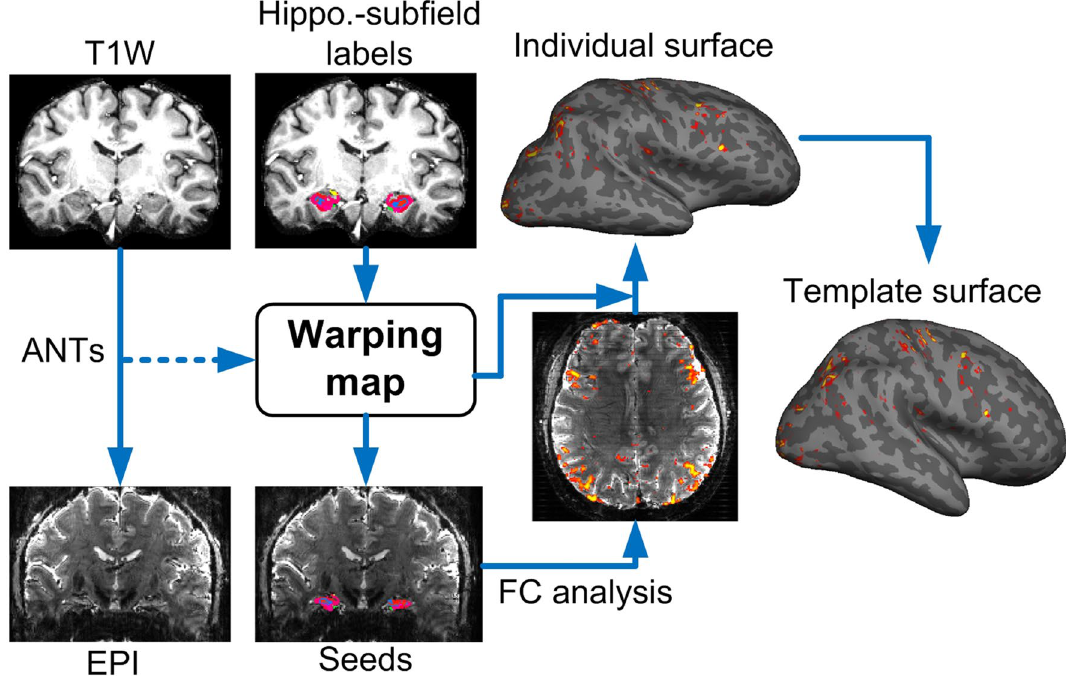
Figure 1. The procedures of coregistration. Individual T1-weighted images were coregistered to the EPI by ANTs. The warping coefficients were then applied to the labeled images of the hippocampal subfields. The seed- based FC analysis was performed on the EPI space and the FC map was re-sampled onto individual cortical surface before being warped to the template surface. The re-sampling of FC values on EPI space captured only the signal from the white matter surface to the middle depth of cerebral cortex in order to suppress contamination from large